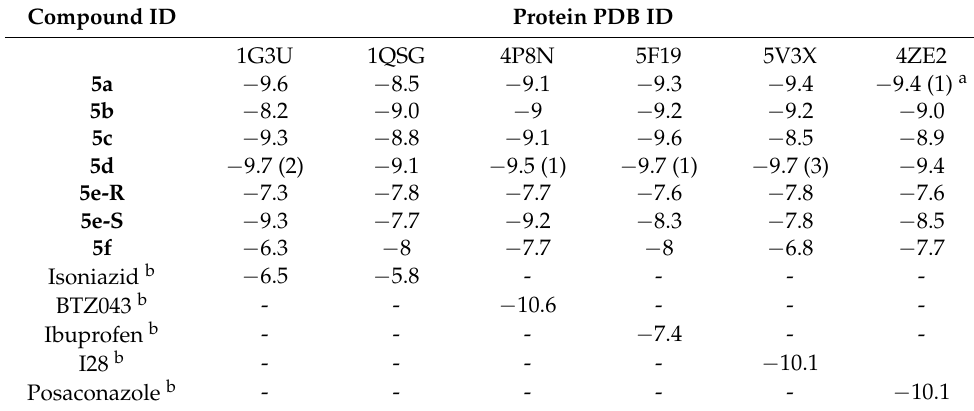
Table 5. Binding energy data for the triazoles 5a – f and control molecules (in kcal mol − 1